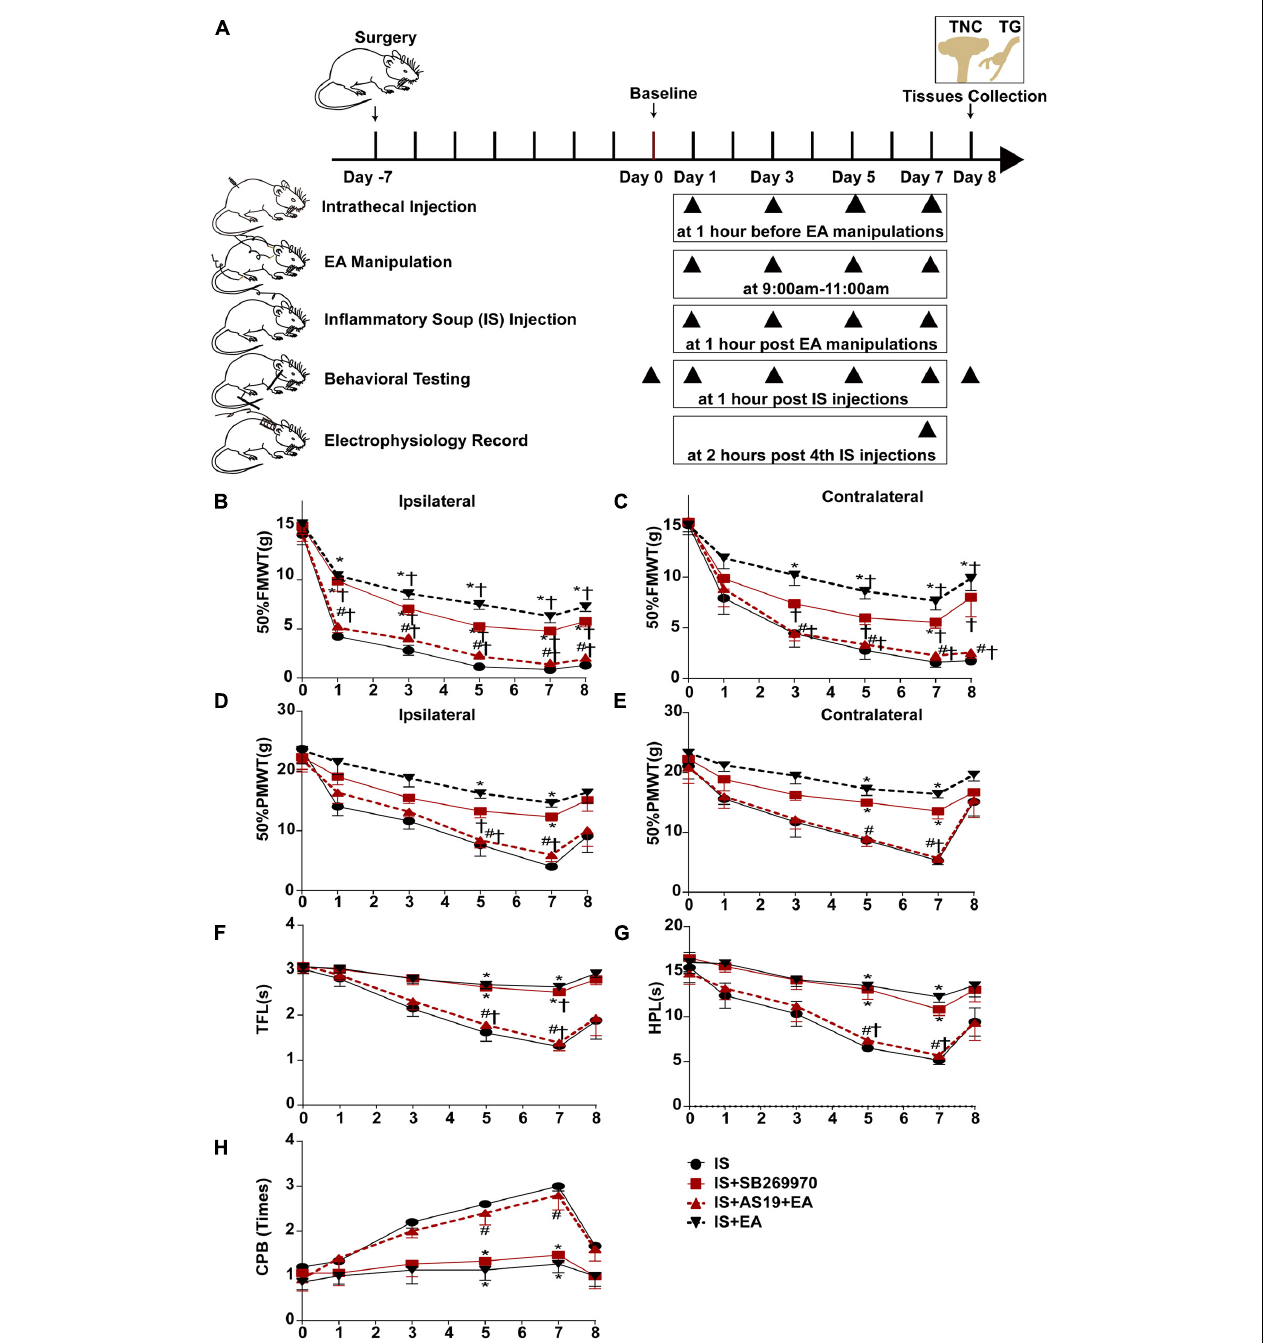
FIGURE 7 | Injecting 5-HT 7 R agonist AS19 or 5-HT 7 R antagonist SB269970 into the intrathecal space of IS rats, evaluated the roles of 5-HT 7 R in EA’s antihyperalgesic effects. (A) Scheme of the experimental design. Rats were injected 5-HT 7 R agonist AS19 or 5-HT 7 R antagonist SB269970 into the intrathecal space, following EA manipulation application and repeated-dural IS injection on days 1, 3, 5, and 7, then measurements of 50%FMWT, 50%PMWT, TFL, HPL, and CPB to examine the extent of mechanical and thermal hyperalgesia after 1 h of IS injection, and also the day 0 without IS injection and 1 day after the 4th IS injection (day 8). Changes in mechanical [50% FMWT (B,C) and 50% PMWT (D,E) ] and thermal [TFL (F) , HPL (G) , and CPB (H) ] hyperalgesia in IS, IS + SB269970, IS + AS19 + EA, and IS + EA groups on days 0, 1, 3, 5, 7, and 8 ( n = 5). The repeated-measure two-way ANOVA post hoc Tukey multiple comparisons test was used. Group values are indicated by mean ± SEM. * P < 0.05 compared with the IS group; # P < 0.05 compared with the IS + EA group at the same time point; † P < 0.05 compared with the baseline on day 0; 5-HT 7 R, 5-hydroxytryptamine (5-HT) 7 receptor; 50%FMWT, 50% facial mechanical withdrawal threshold; 50%PMWT, 50% paw mechanical withdrawal threshold; TFL, tail-flick latency; HPL, hot-plate latency; CPB, cold-plate behaviors; EA, electroacupuncture; IS, inflammatory soup; AS19, 5-HT 7 R agonist; SB269970, 5-HT 7 R